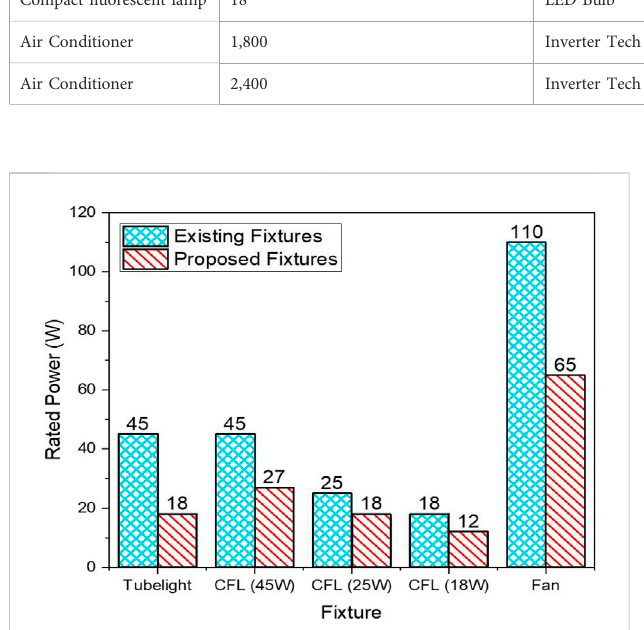
FIGURE 2 Comparison of energy consumption in tube light, compact fl uorescent lamp (CFL), and fan.